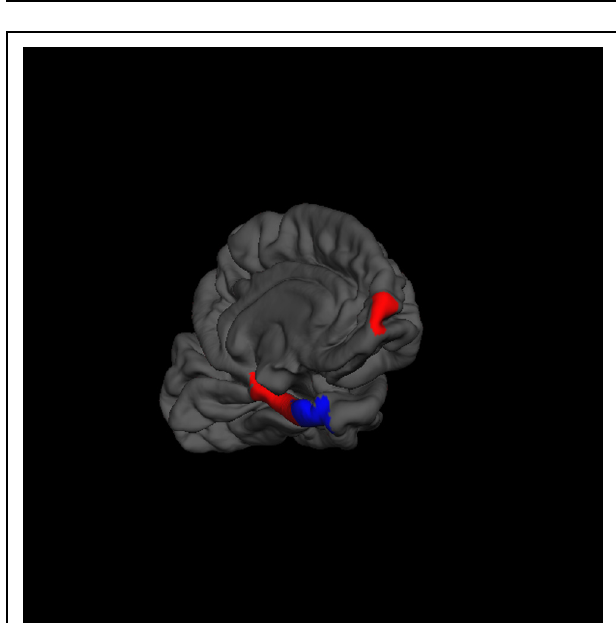
FIGURE 5 | FreeSurfer rendering of the left hemisphere pial surface with the left frontal pole, parahippocampal gyrus, and entorhinal gyrus indicated (inferior frontal view), showing positive (red) and negative (blue) associations between cortical thickness and increased creativity on the Foresight